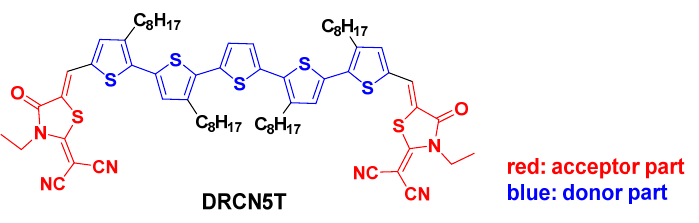
Figure 1. Molecular structure of DRCN5T.